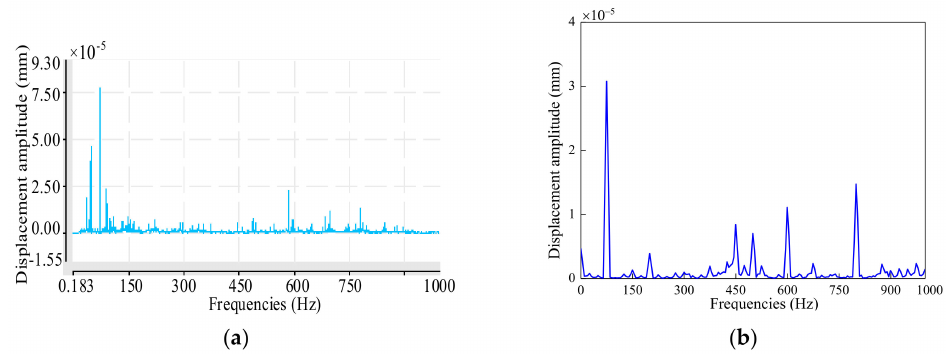
Figure 12. Comparison of frequency spectrum of vibration displacement. ( a ) Measured vibration spectrum; ( b ) Simulated vibration